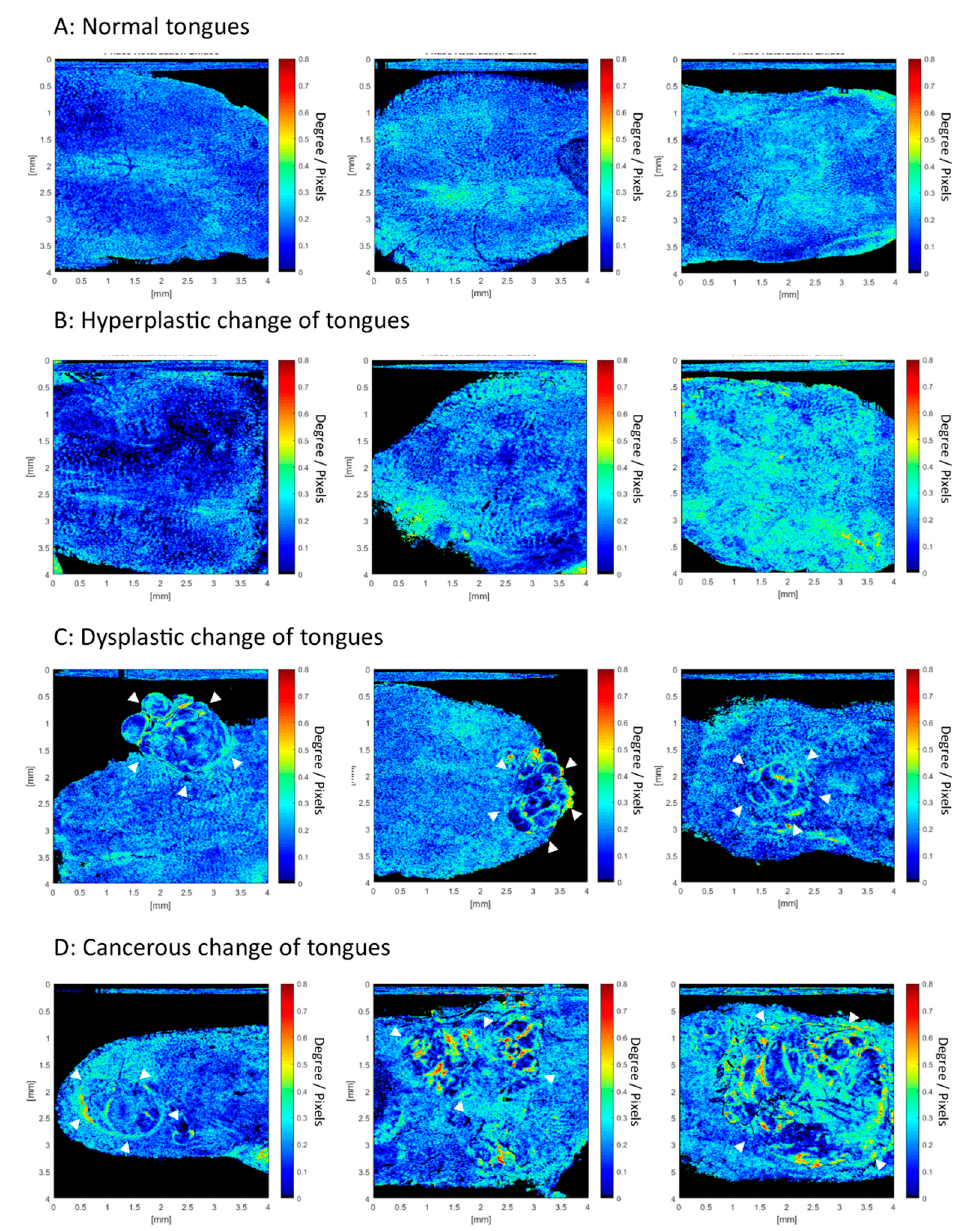
Figure 4. En-face birefringence maps from normal to cancers. ( A ) Bright spots against a dark blue background were seen in a normal tongue. ( B ) Crowded and blurred bright spots against a dark blue background in hyperplastic change. ( C , D ) Apparent malignant lesions (white arrowheads), with a low birefringence background and highly birefringent capsule and septum that can be seen clearly. Table 1. Results of histology and en-face birefringence map in all specimens. Maximal Tumor Diameter by Maximal Tumor Diameter by Mice Histology Histology Birefringence Map